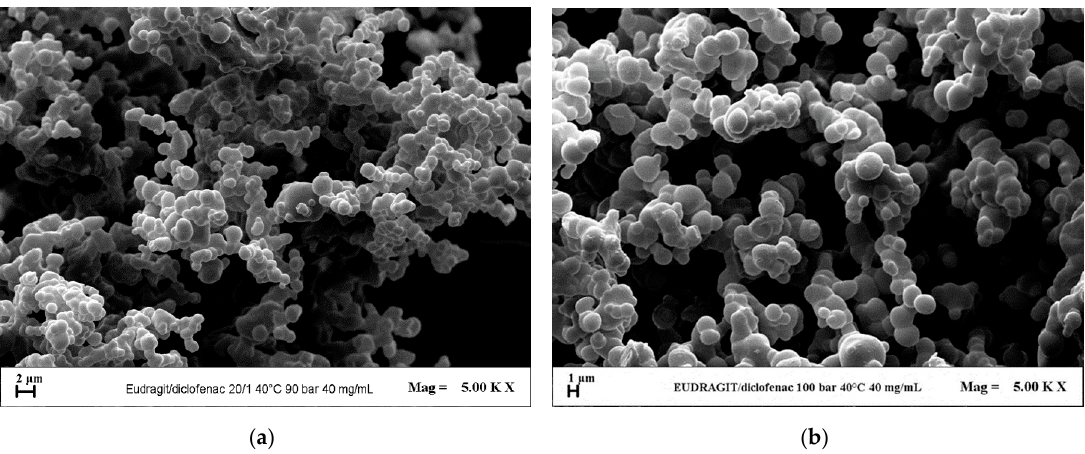
Figure 5. FESEM images of EUD/DICLO 20/1 particles precipitated from DMSO at 40 °C and 40 mg/mL. Effect of the operating pressure. ( a ) 9 MPa (run #6); ( b ) 10 MPa (run #7).